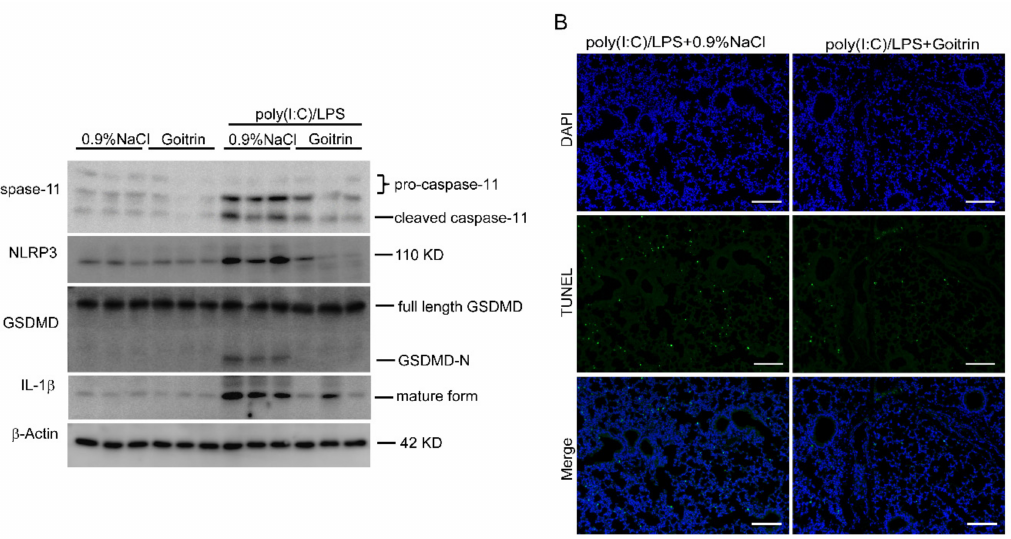
Figure 9. Goitrin inhibited caspase-11 non-canonical inflammasome activation poly(I:C)/LPS- mediated mice. Mice were primed with poly(I:C) [4 mg/kg, ip (intraperitoneally)] and challenged 6 h (h) later with LPS (20 mg/kg, ip) in the absence or presence of goitrin (30 mg/kg) or TAK-242 (3 mg/kg), the mice were sacrificed 8 h later ( n = 6). ( A ) Protein levels of caspase-11, cleaved caspase- 11, cleaved GSDMD (GSDMD-N), NLRP3, and mature IL-1 β were analyzed in lung tissues ( n = 3). ( B ) DNA breakage was assayed by the TUNEL method in lung tissues ( n = 6). (scale bar = 50 µ